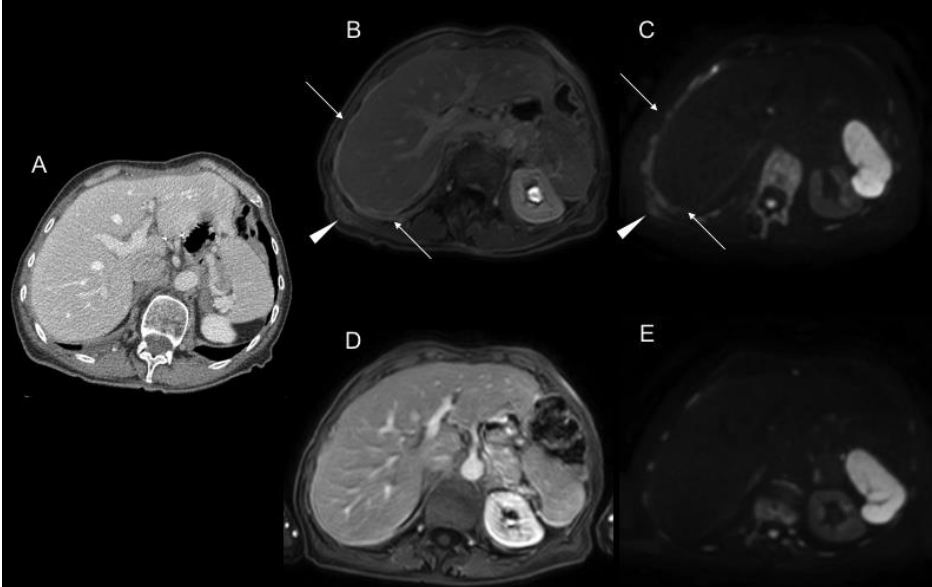
Figure 9. A 69-year-old female patient with diffuse gastric adenocarcinoma treated with total gastrectomy who presented progressive elevation of CA19.9 tumour marker during the follow-up. Portal phase contrast-enhanced CT axial image ( A ) show no findings. In initial MR images postGd DIXON axial ( B ) and DWI b1000 axial ( C ) we can see abnormal perihepatic enhancement and restricted diffusion (arrows), with involvement of the right dorsal muscle (arrowheads), consistent with tumour recurrence. Only a subtle perihepatic enhancement can be seen in the first MR images ( D , E ) post neoadjuvant chemotherapy.